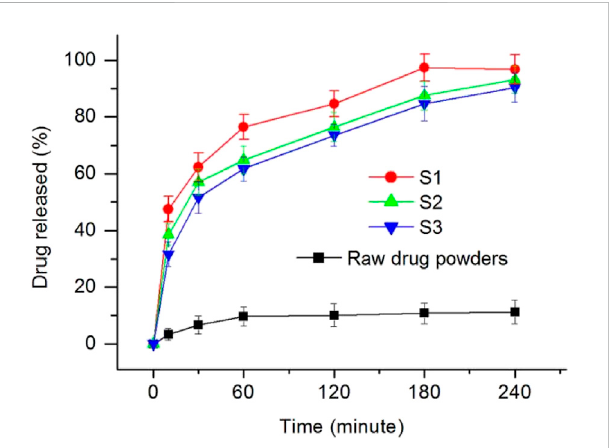
FIGURE 8 In Vitro drug release pro fi les from the nano fi bers S1, S2, S3 and the raw PTX